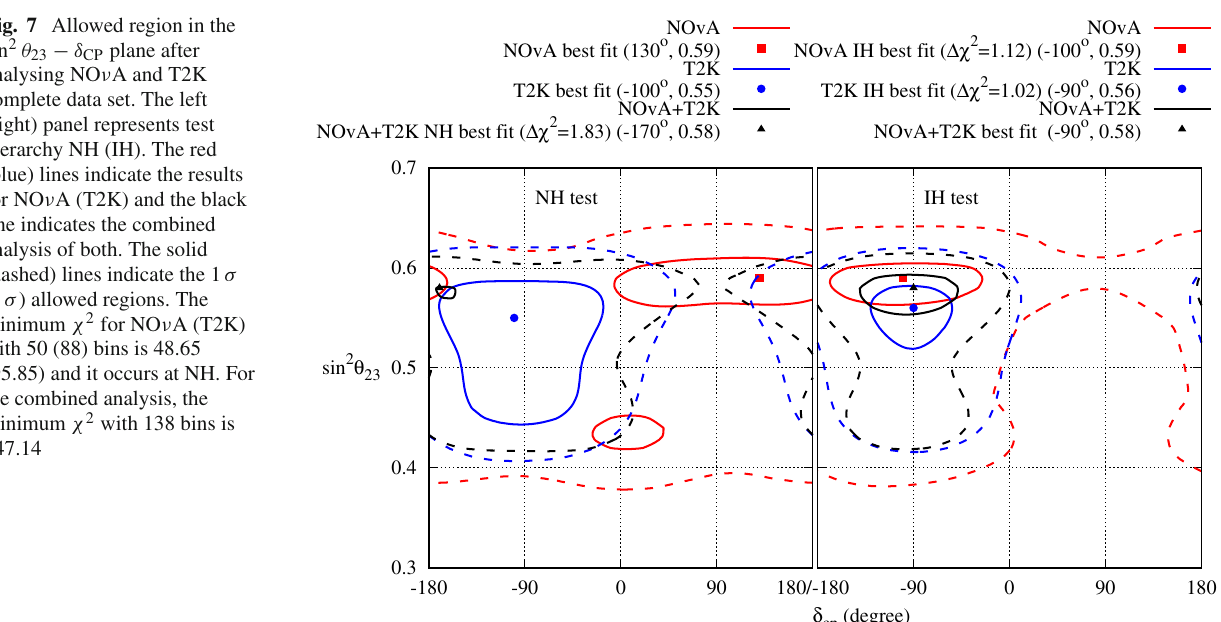
Fig. 7 Allowed region in the sin 2 θ 23 − δ CP plane after analysing NO ν A and T2K complete data set. The left (right) panel represents test hierarchy NH (IH). The red (blue) lines indicate the results for NO ν A (T2K) and the black line indicates the combined analysis of both. The solid (dashed) lines indicate the 1 σ (3 σ ) allowed regions. The minimum χ 2 for NO ν A (T2K) with 50 (88) bins is 48.65 (95.85) and it occurs at NH. For the combined analysis, the minimum χ 2 with 138 bins is